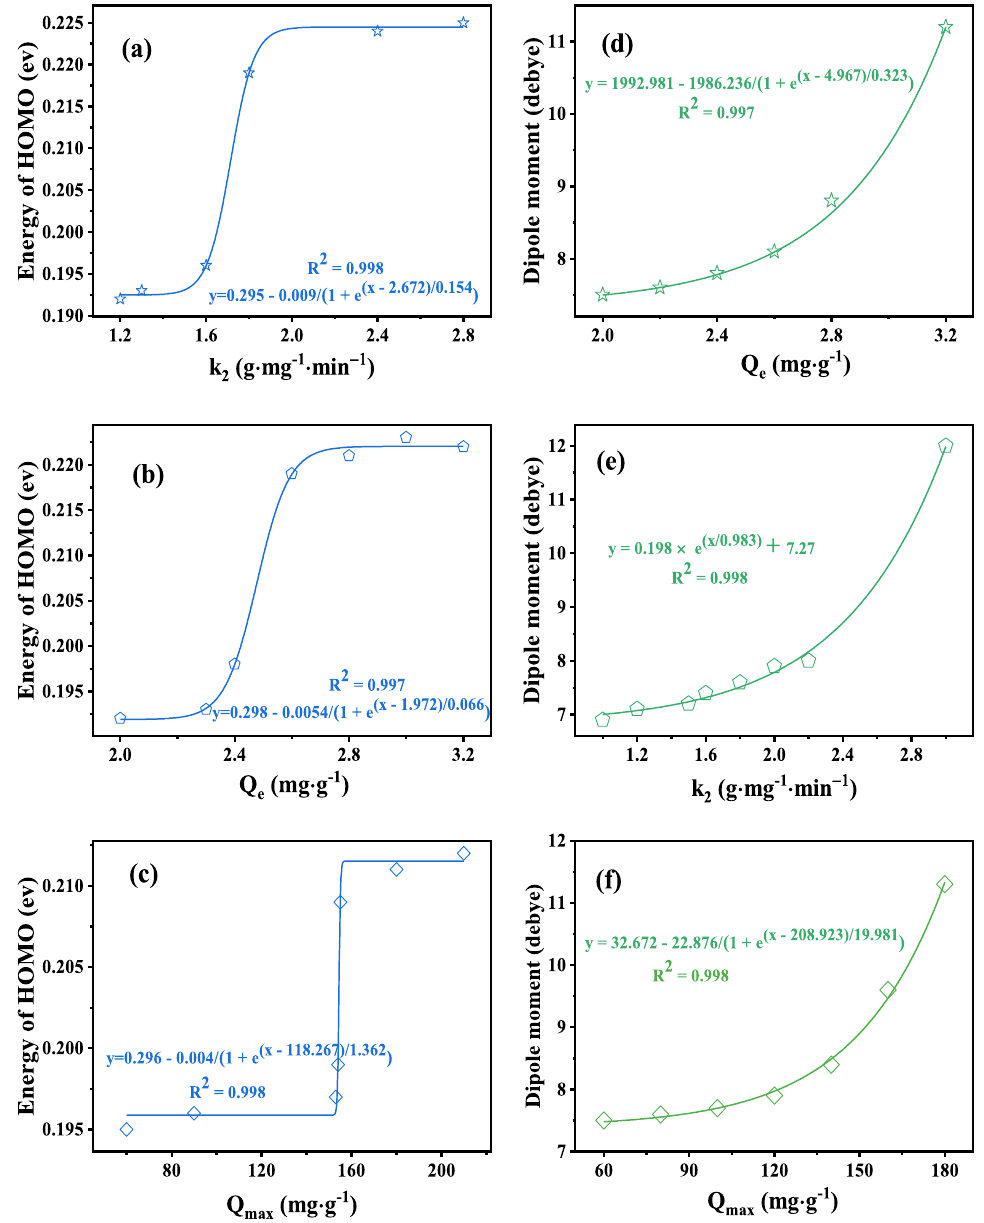
Fig. 9 The relationship between E HOMO —adsorption affinity ( a , b , c ) and μ—adsorption affinity ( d , e , f ): calculated by pseudo—second—order kinetic model and Langmuir isotherm